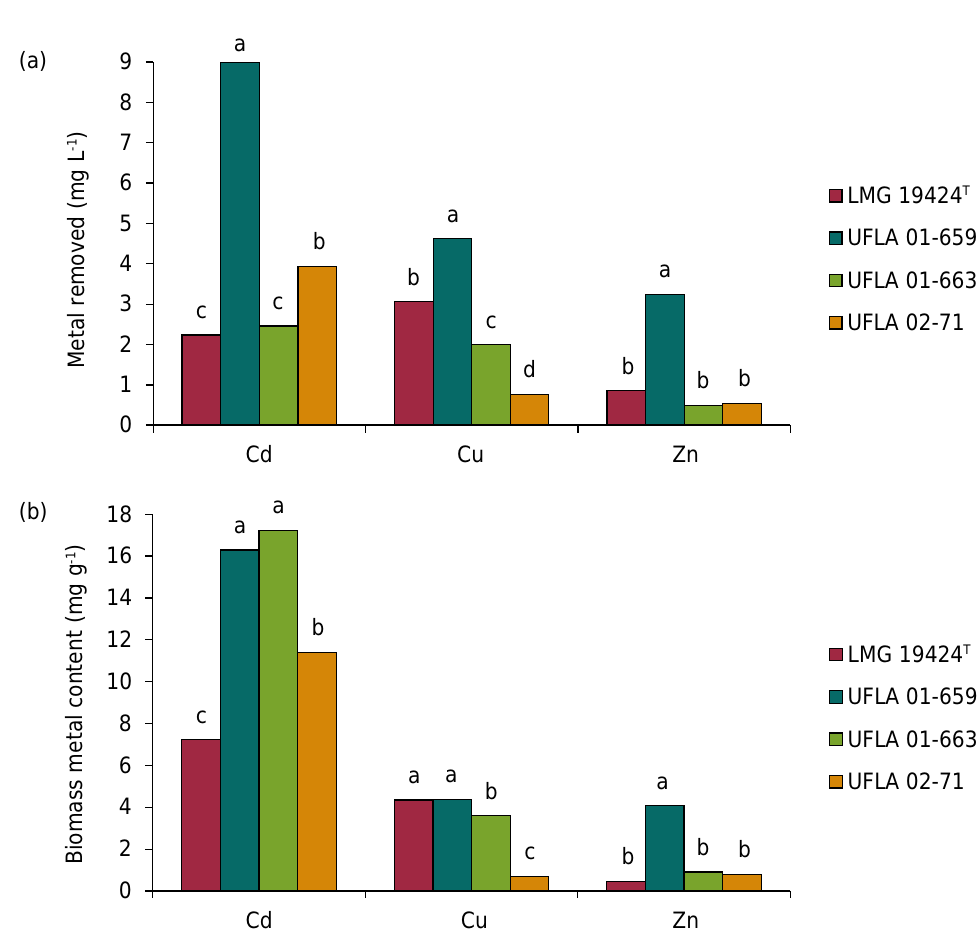
Figure 2. Metal removed from the liquid LB culture medium supplemented with Cd (1 mmol L -1 ), and Cu and Zn (2 mmol L -1 ) by bacterial strains (LMG 19424 T , UFLA 01-659, UFLA 01-663, and UFLA 02-71), and heavy metal contents in the biomass of these